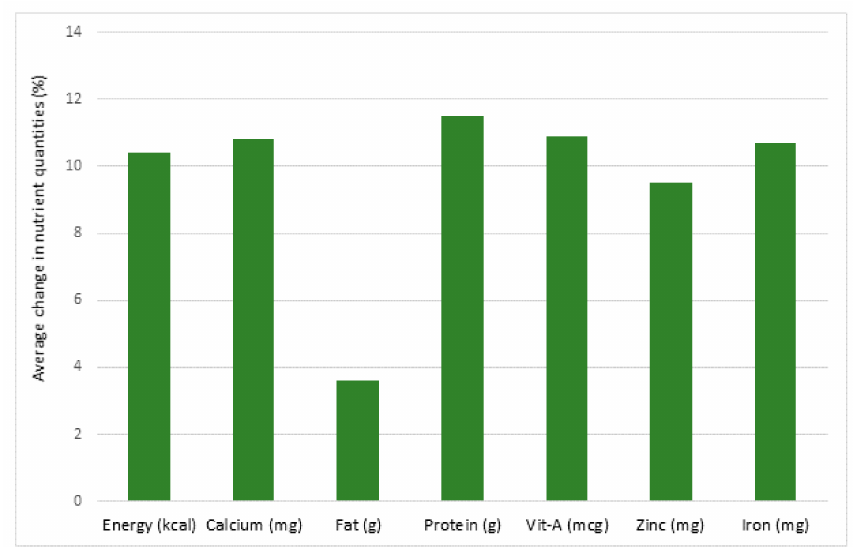
Figure 1. Average decrease in nutrient quantities (%) for school meals in Nepal between June 2019 (pre-coronavirus disease 2019 (COVID-19)) and May/June 2020 (post-COVID-19), due to food price inflation. (mg: milligram; mcg:microgram; g:gram; kcal:kilocalorie)